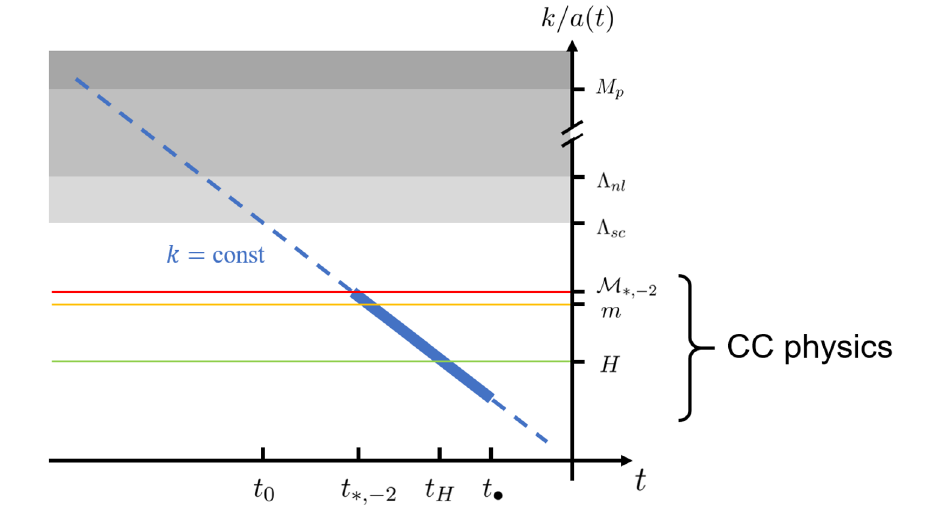
Figure 2 . A schematic illustration of the life of a helicity λ = − 2 mode with constant comoving momentum k . The horizontal axis is time and the vertical axis represents the redshifted physical momentum of this mode. The blue line is dashed when the mode is at the vacuum and is solid when it is occupied by particles. The characteristic events are t 0 : the mode emerges out of the cutoffs as the BD vacuum, t ∗ , − 2 : particle production with chemical potential, t H : horizon-crossing, t • : the particle decays into inflatons and gravitons, with the mode going back to vacuum. The whole CC process occurs well below the strong-coupling scale and the non-linear scale of time diffeomorphism, and is under perturbative